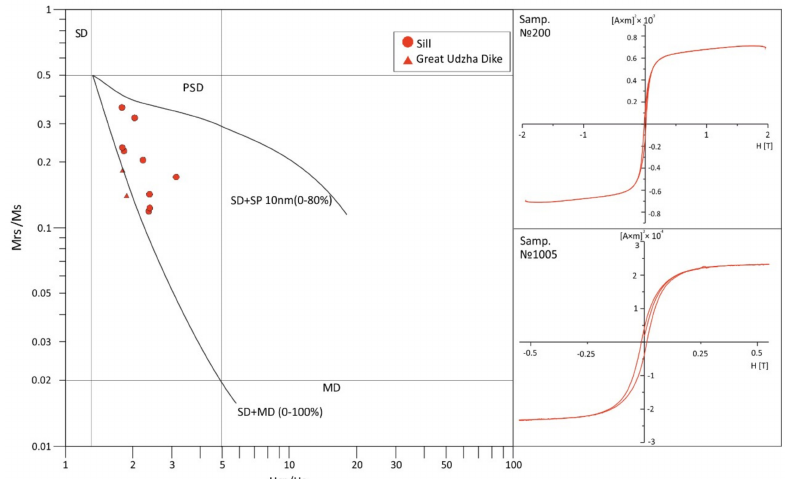
Figure 7. Plot of hysteresis parameters and hysteresis loops samples from the Great Udzha Dyke and the sill at the Udzha and Haphanyr river junction (Mrs/Ms = ratio of saturation remanence to saturation magnetization; Hcr/Hc = ratio of coercivity of remanence to coercivity) from samples plotted against the canonical fields [8–10] of single-domain (SD), pseudo-single-domain (PSD) and multi-domain (MD) magnetite. In the diagram, the values of the hysteresis parameters are located in the field of pseudo-single-domain grains. Right—characteristic hysteresis loops of the GUD (No. 200) and sill (No. 1005) samples are